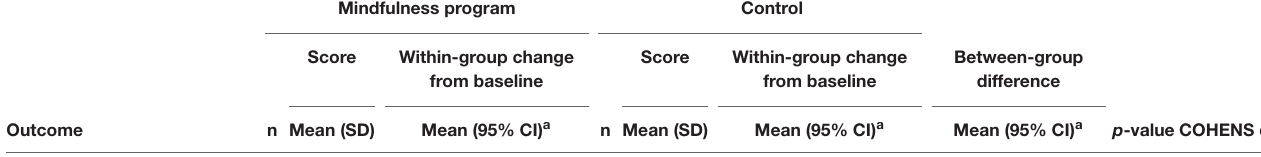
TABLE 3 | Effects of a mindfulness program including MBSR on mediator outcomes among students at VIA’s undergraduate program for teacher education ( n = 67) 3 months from baseline, Denmark, 2019 and